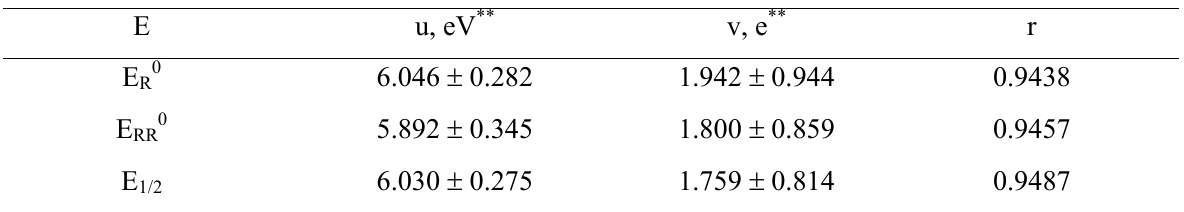
values ( vs saturated Hg 1/2